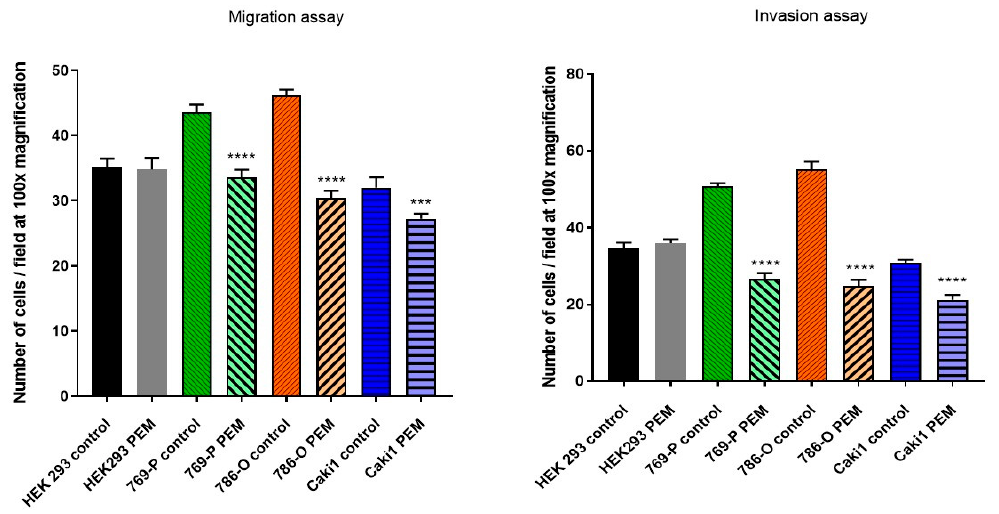
Figure 4. Number of cells migrating towards chemoattractant (average of 5 fields at 100 × total magnification). (***— p < 0.0005; ****— p < 0.00005).